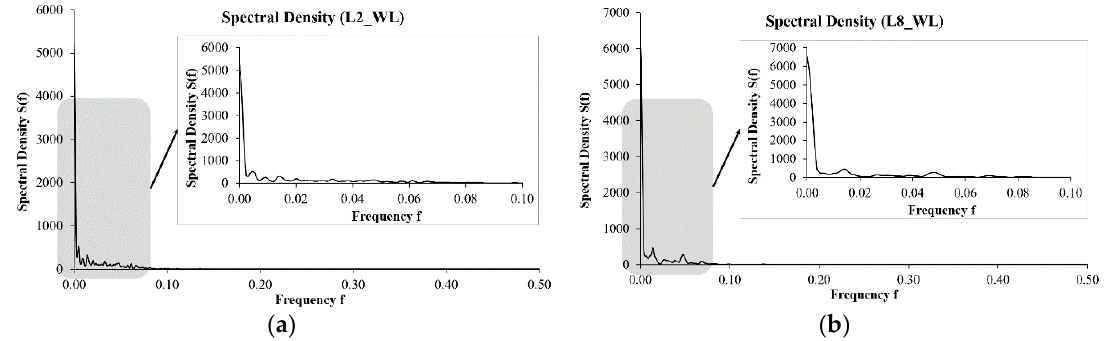
Figure 15. ( a ) Spectral density versus frequency for water level data of L2; ( b ) spectral density versus frequency for water level data of L8.